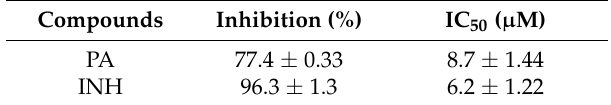
Table 4. Inhibitory activities of PA and INH against